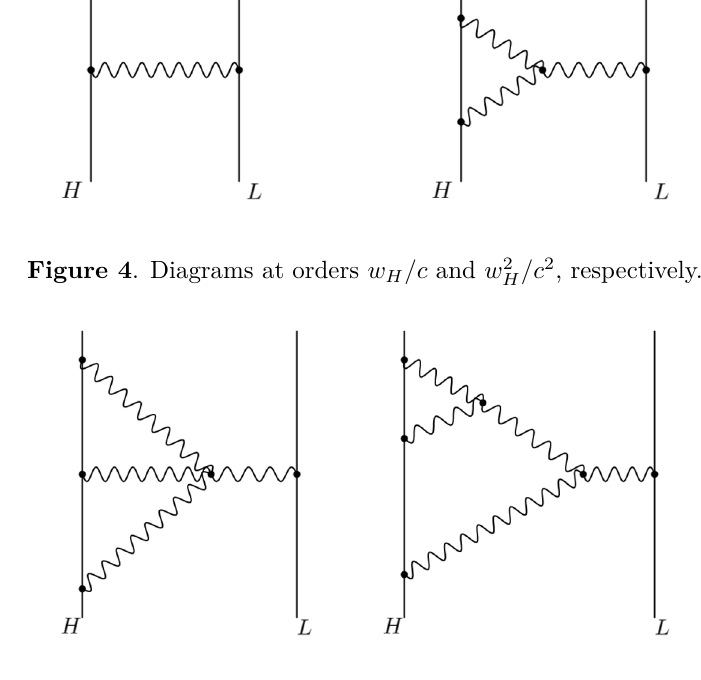
Figure 5 . Diagrams at order w 3